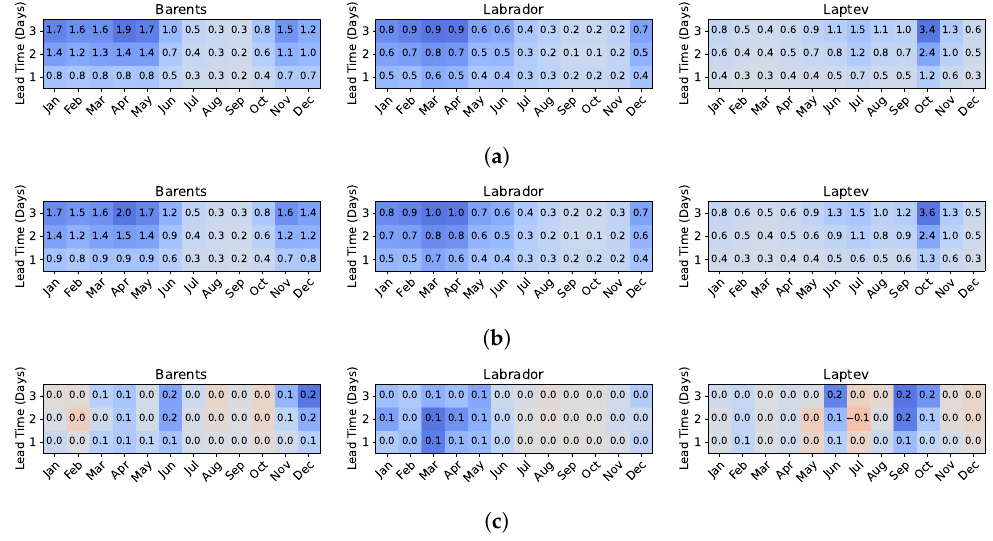
Figure 7. Improvement of JAXA SIC MAE (in percentage points, higher is better) for different models compared to the other models or baselines for different months of 2021 and days of the forecast. The matrix for each region and subfigure is color-coded independently in a red-blue scheme to provide a better perception of the relative improvement for each month and forecast day in the corresponding region. The numbers in each cell are rounded and should be used to estimate the overall improvement scale in the regions. Improvement is computed in absolute percentage points and tends to be higher for months with active sea ice change. ( a ) General U-Net (S) with GFS over persistence. ( b ) General U-Net (R) with GFS over persistence. ( c ) General U-Net (R) with GFS over general U-Net (S) with GFS.